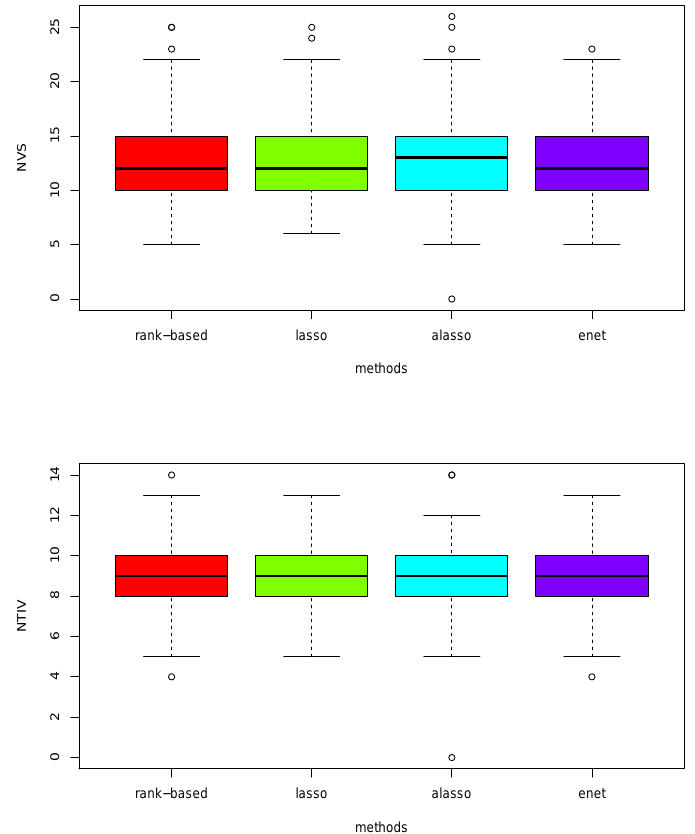
Figure 3. Boxplots of total number of variables (NVS) selected and the number of true important variables (NTIV) within the number of variables selected with four different models on scenario 2 based on 200